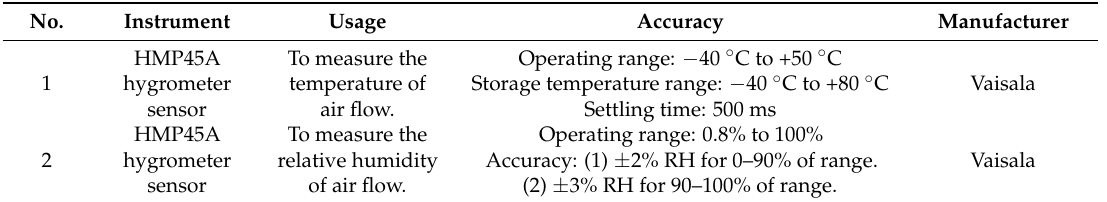
Table 6. Details of instrumentation for the experimental testing by Qui